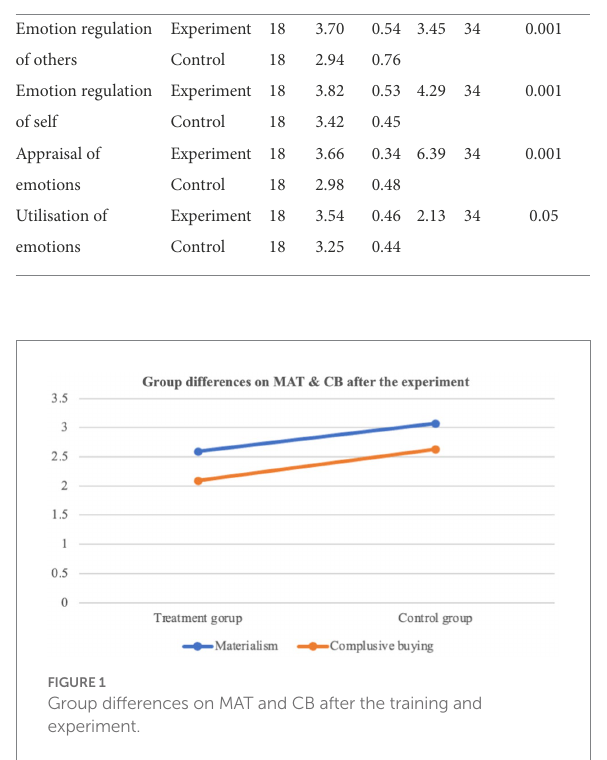
TABLE 1 Group statistics on emotional intelligence dimensions. EI dimensions GROUP N Mean SD